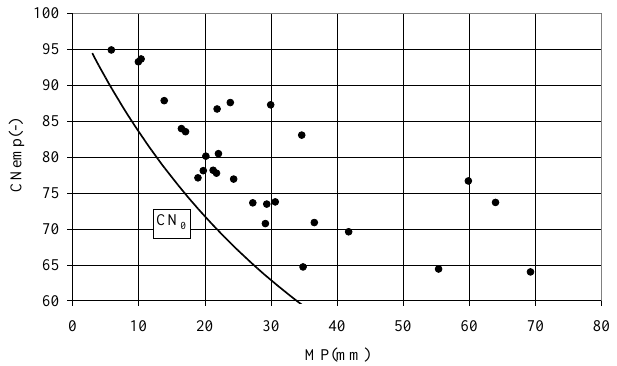
Figure 2. CN vs. MP . CN 0 represent a threshold, below which no runoff occurs until the snowmelt MP in mm exceeds an initial abstraction of 20% of the maximum potential